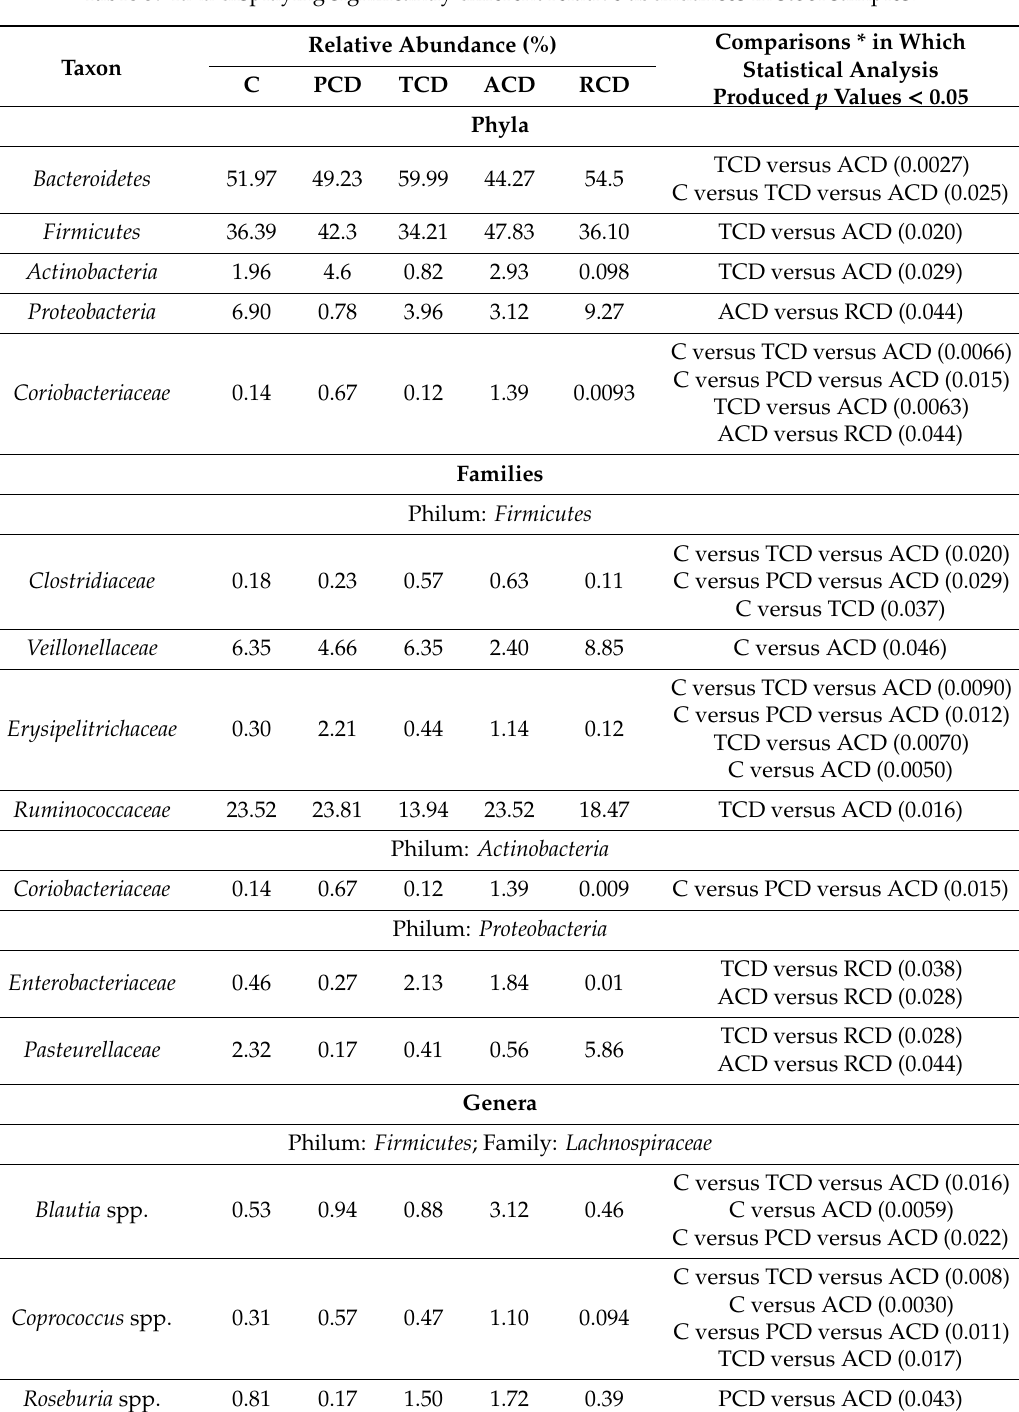
Table 5. Taxa displaying significantly di ff erent relative abundances in stool